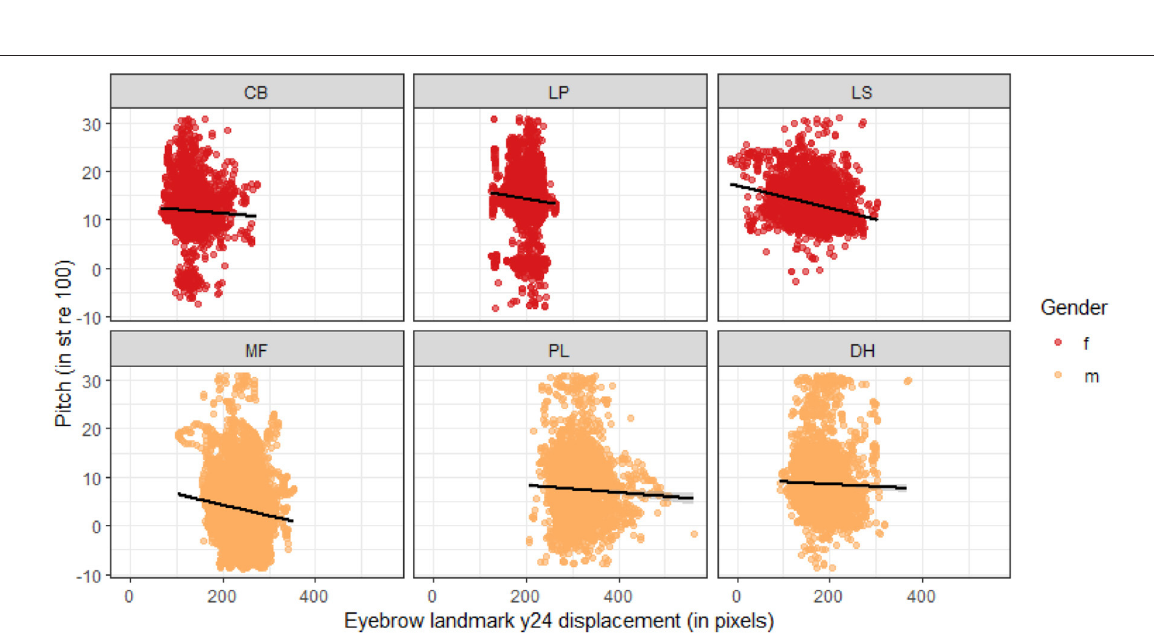
FIGURE 4 | Correlations between pitch (in semitones) and the intensity of AU05 (upper lid raiser) for each of the six speakers.